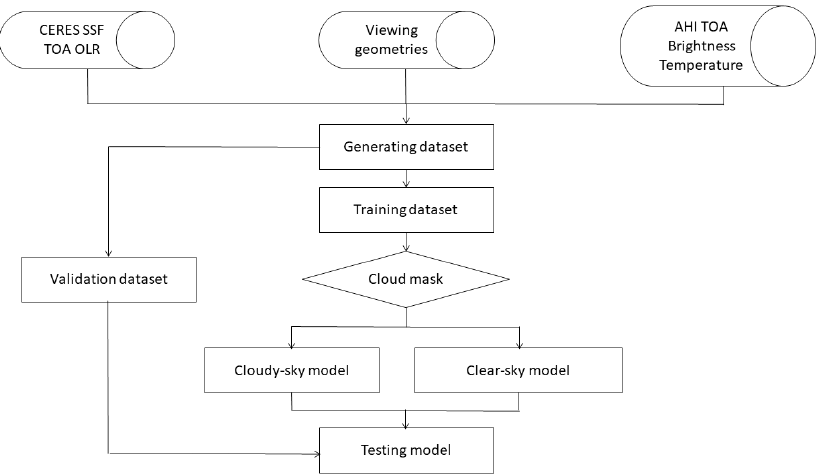
Figure 1. Flowchart of TOA OLR estimation from AHI data.